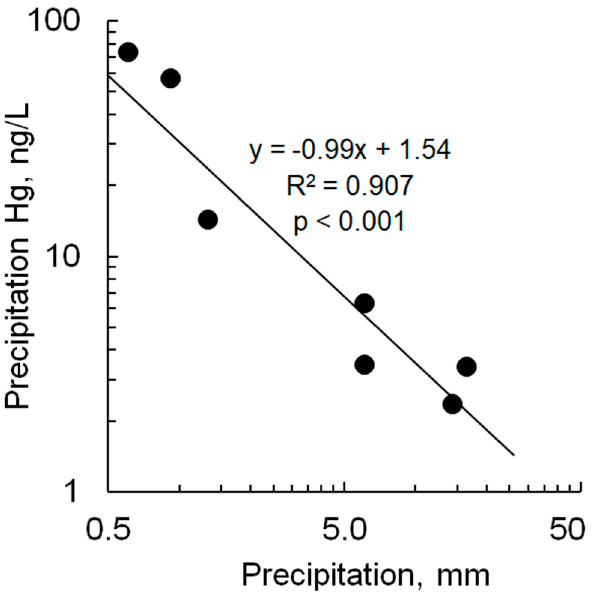
Figure 4. Relationship between Hg concentration in precipitation and precipitation depth for data for Pullman and Puyallup, WA. Line is linear regression. for Pullman and Puyallup, WA. Line is linear